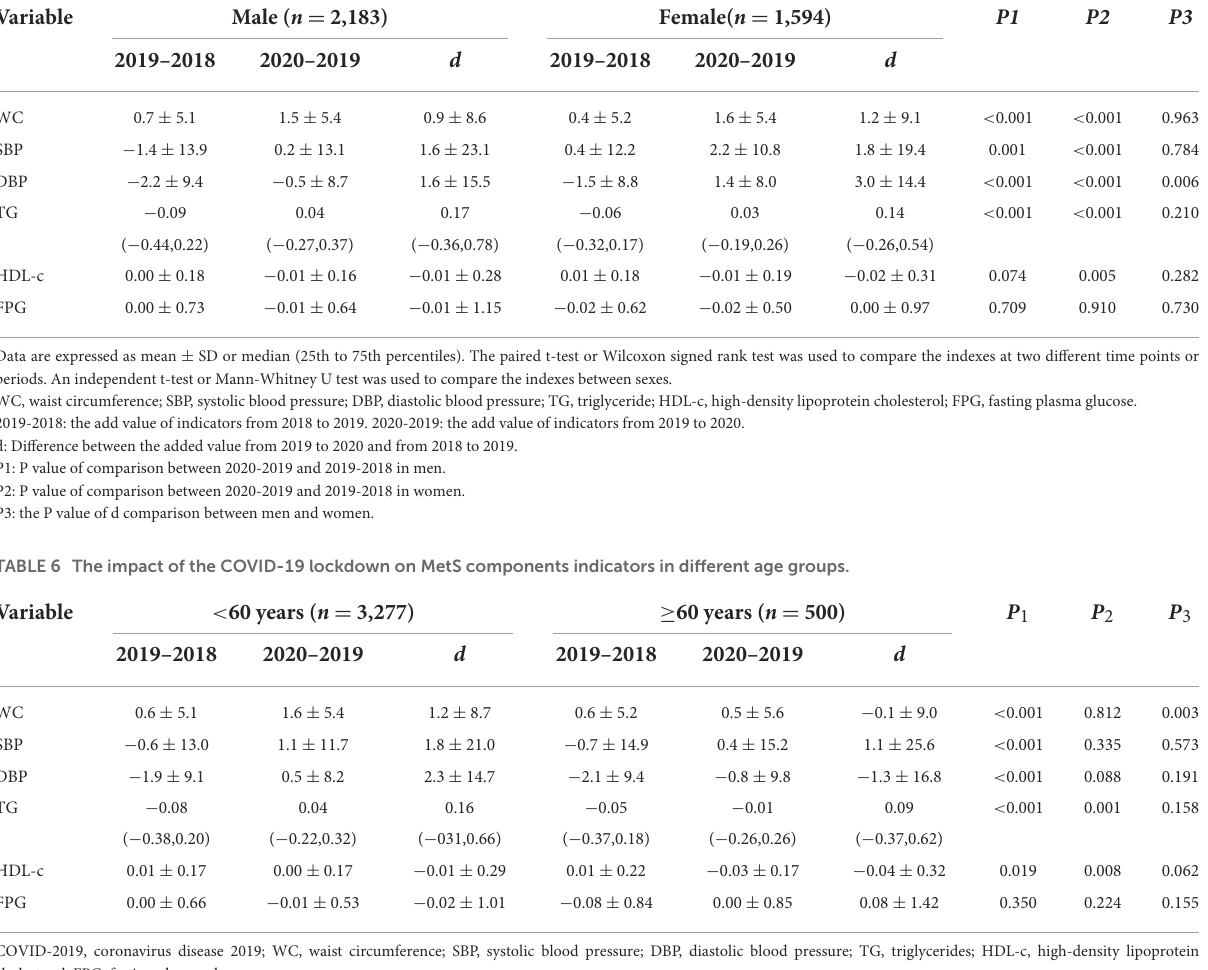
TABLE 5 The impact of COVID-19 lockdown on MetS component indicators in different sexes. Variable